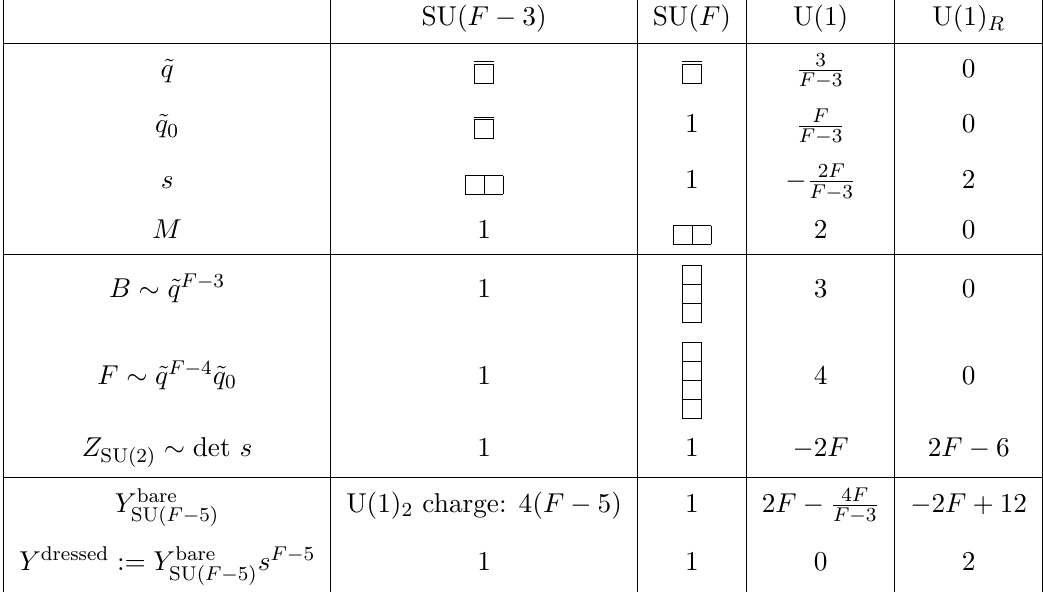
Table 7 . The SU( F (cid:0) 3) magnetic dual description of table